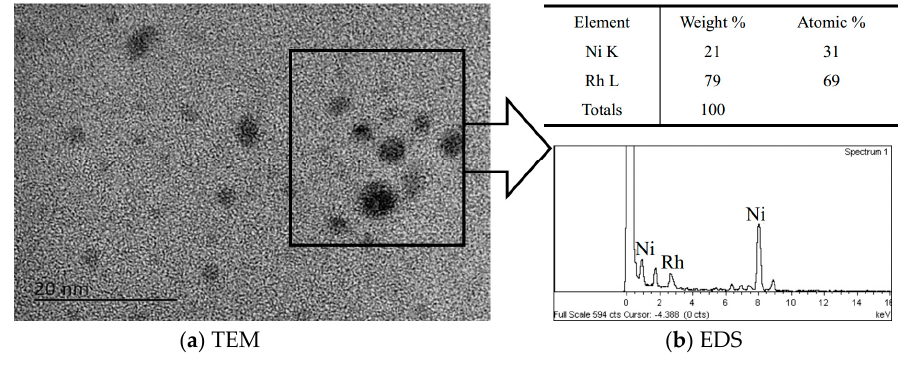
Figure 3. TEM image ( a ) and mapping ‐ EDS ( b ) of Rh 70 Ni 30 BNPs ( R ISO = 40, C Metal = 0.66 mM, reduced under ice ‐ water bath for 1 h).